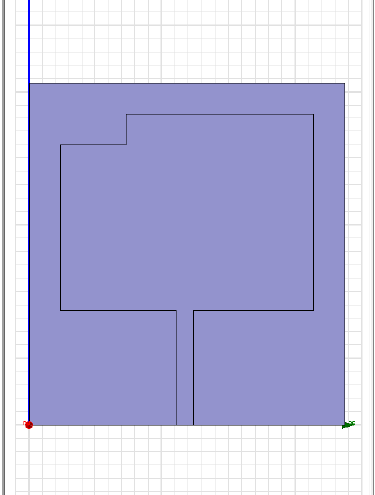
Fig. 4. Antenna (final) with a rectangular slot